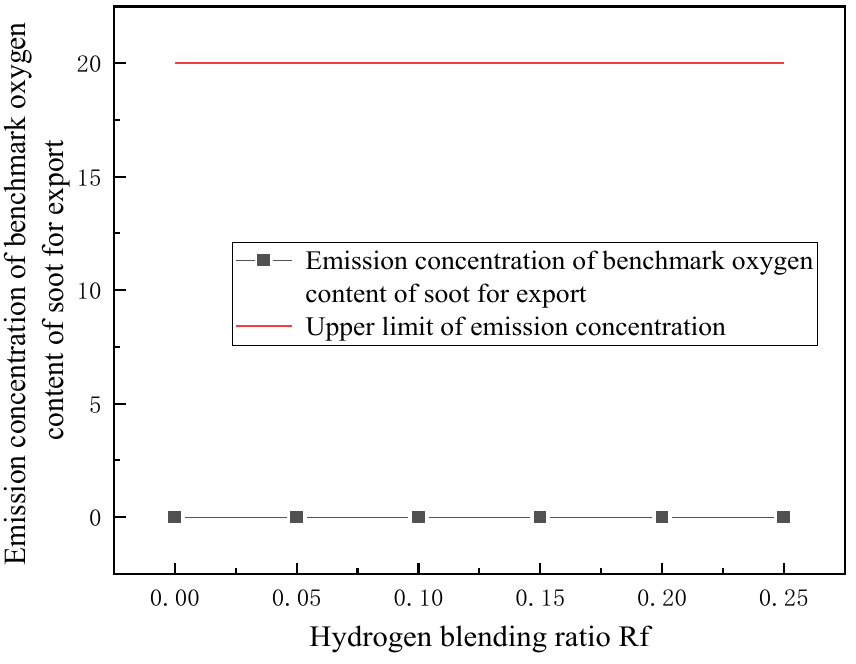
Figure 16. Emission concentration and limit standard of oxygen content of soot for export.